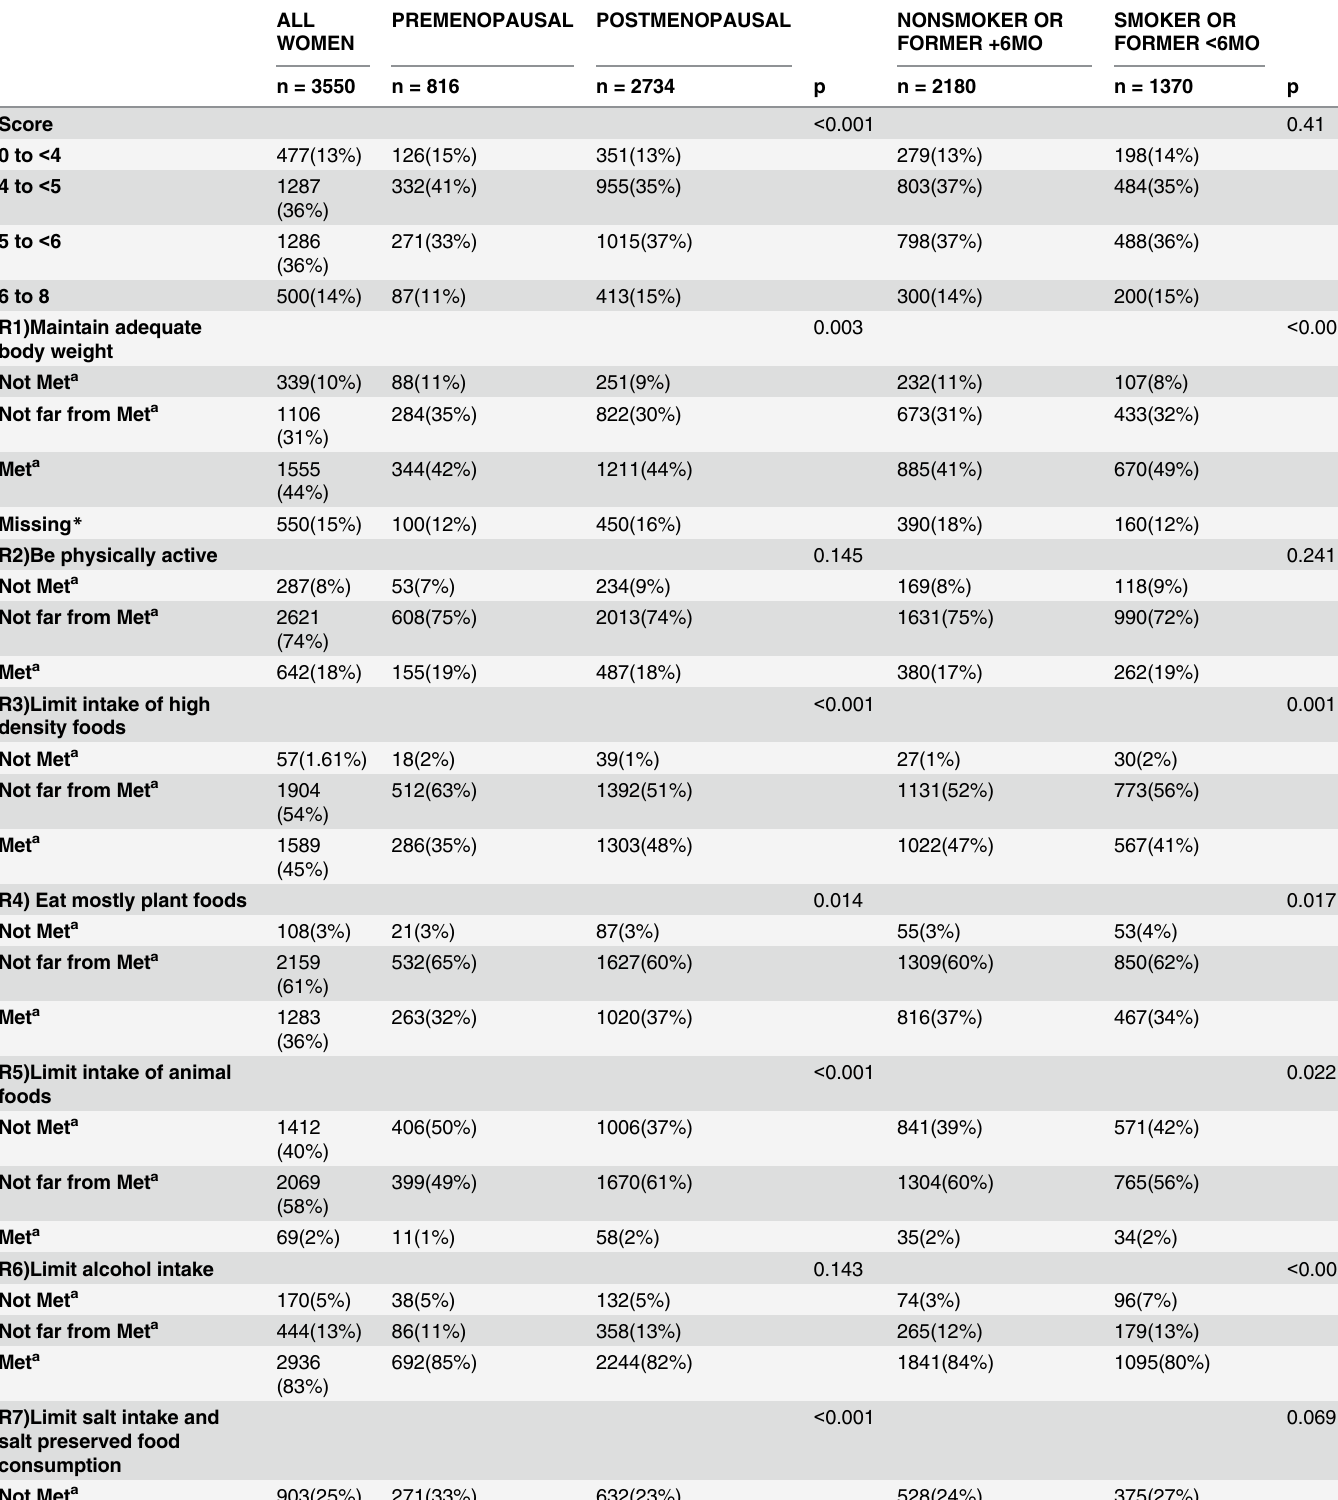
Table 2. Description of all women ’ s characteristics and by menopausal status and by smoking habit. ALL